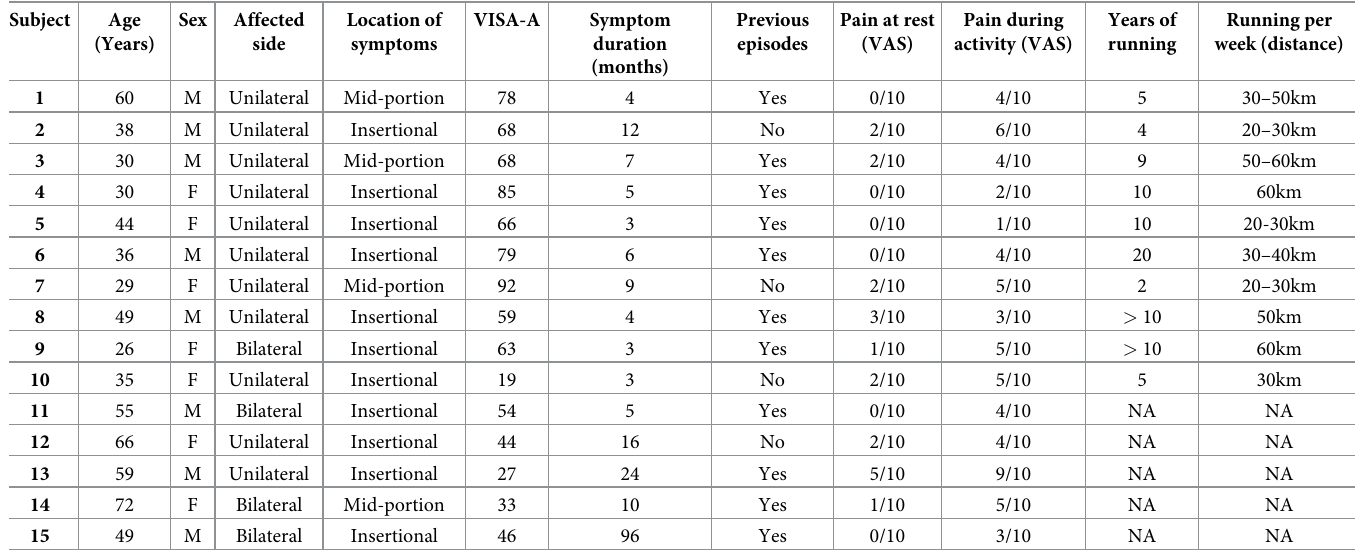
Table 1. Individual demographics, subjective, and objective data.